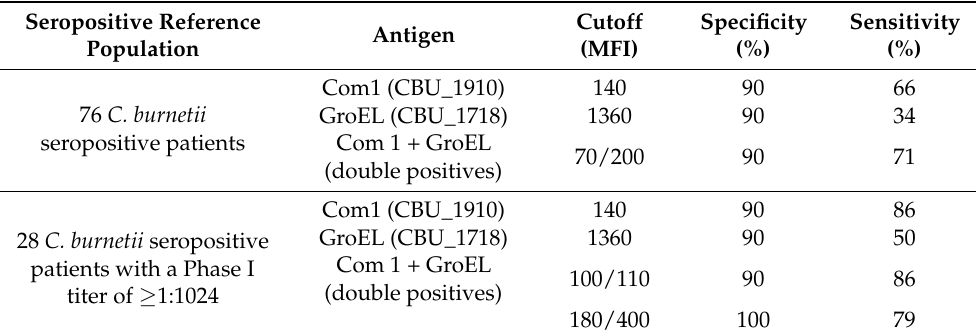
Table 5. Final multiplex serology assay characteristics and performance of antigens Com1 and GroEL, as well as a combination of both antigens. Assay performance was determined in an overall C. burnetii positive population (n = 76) and a subgroup with high Phase I endpoint titers of ≥ 1:1024, as an approximation for chronic Q fever (n =